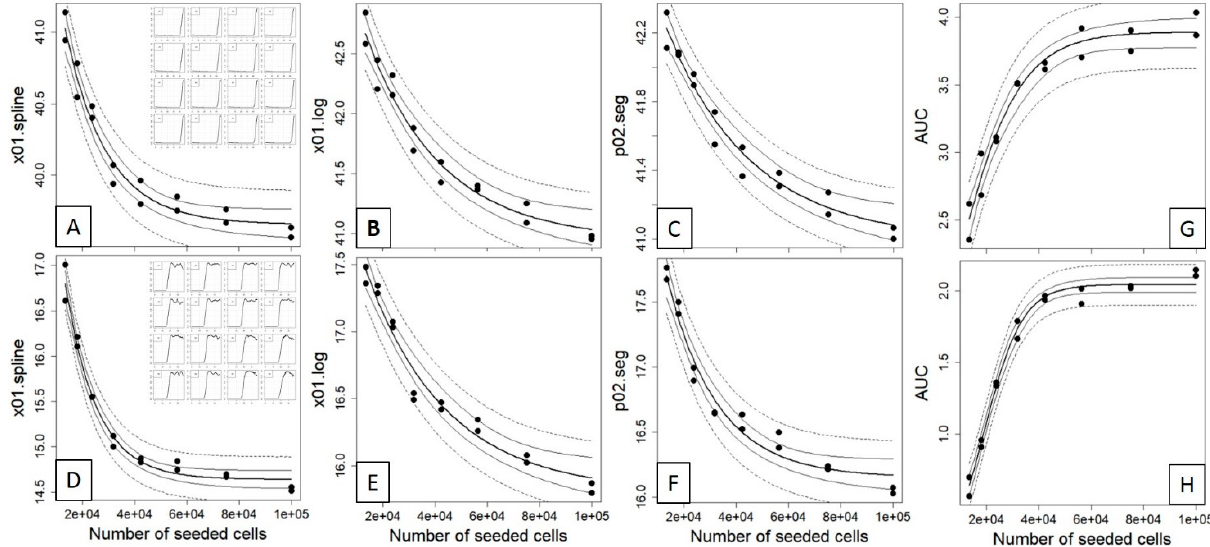
Figure 3. Nonlinear correlation between the seeded cell counts and the time estimated from the 0.1 quantile value of a spline ( A , D ), four-parameter logistic ( B , E ) and the 0.2 quantile value of segmented regression ( C , F ) of time vs. impedance (compare Figure 2 and Supplemental Data 2) for a 6 h (upper panel) and a plateau phase (lower panel) experiment, see insets. An exponential decay model y = ( y 0 − y b ) × exp( − kx ) + y b was fitted to the data and displayed as fitted values (bold line), 95% confidence interval (thin line) and 95% prediction interval (dashed line). For both datasets, the area under the curve (AUC) was calculated for the complete time scale (( G ); 0–46.9 h) and for a subset (( H ); 0–20 h) and fitted with exponential growth model y = y max /(1 + exp( a + bx )). The corresponding fitted parameters and goodness-of-fit measures for both models are given in Table 2. Table 2. Parameters and goodness-of-fit measures derived from fitting the exponential decay model (spl, log, seg) and the growth model (AUC) to the data in Figure 3. Cut, 6